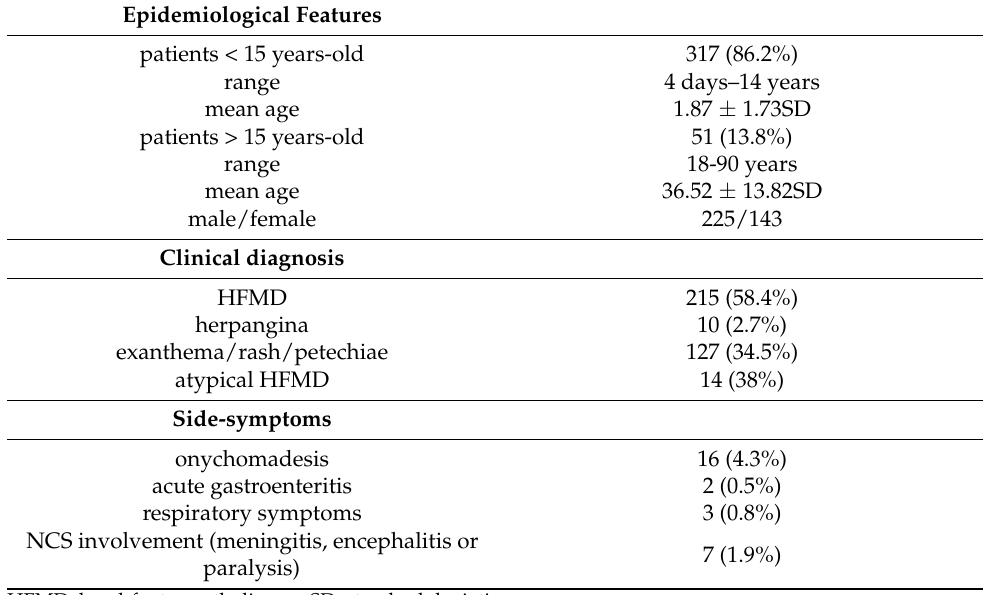
Table 1. Clinical characteristics and symptoms presented by the patients included in the